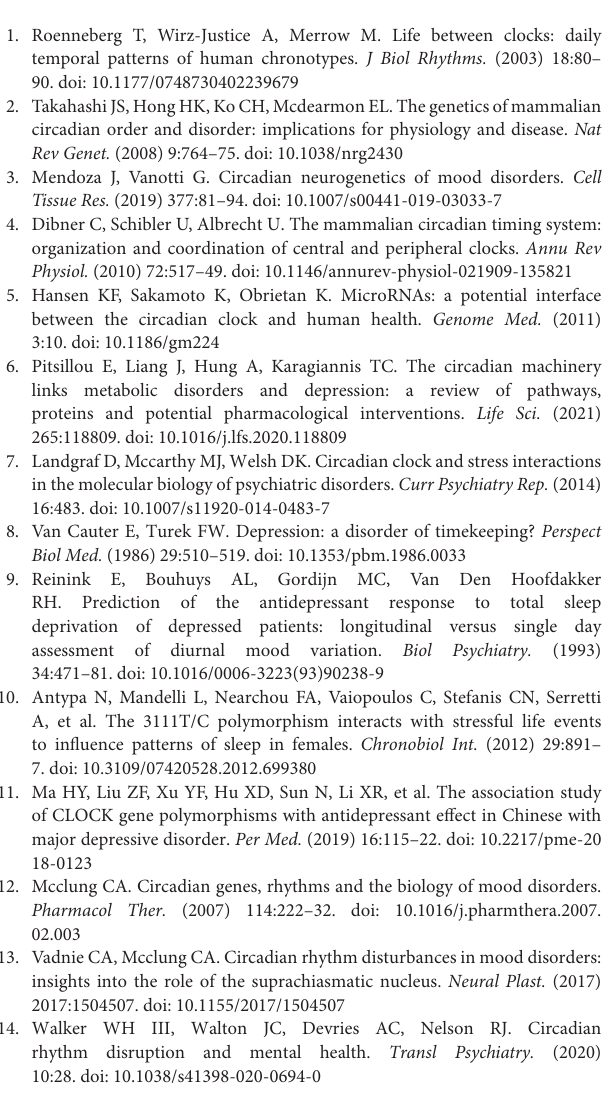
Supplementary Table 2 | Main effect of CLOCK SNPs in the NewMood database surviving quality control on current depressive symptoms (BSI-DEP). Results of linear regression models and quality control steps are shown. While there were nominally significant SNPs, significant clumps could not be identified. Supplementary Table 3 | CLOCK SNPs in the NewMood database surviving quality control, in interaction with recent life events (RLE) on current depressive symptoms (BSI-DEP). Results of linear regression models and quality control steps are shown. SNPs in significant clumps are marked in red, top SNP of the clump is marked in bold red. Results for additive, dominant, and recessive models are shown. Supplementary Table 4 | CLOCK SNPs in the NewMood database surviving quality control, in interaction with childhood adversities (CHA) on current depressive symptoms (BSI-DEP). Results of linear regression models and quality